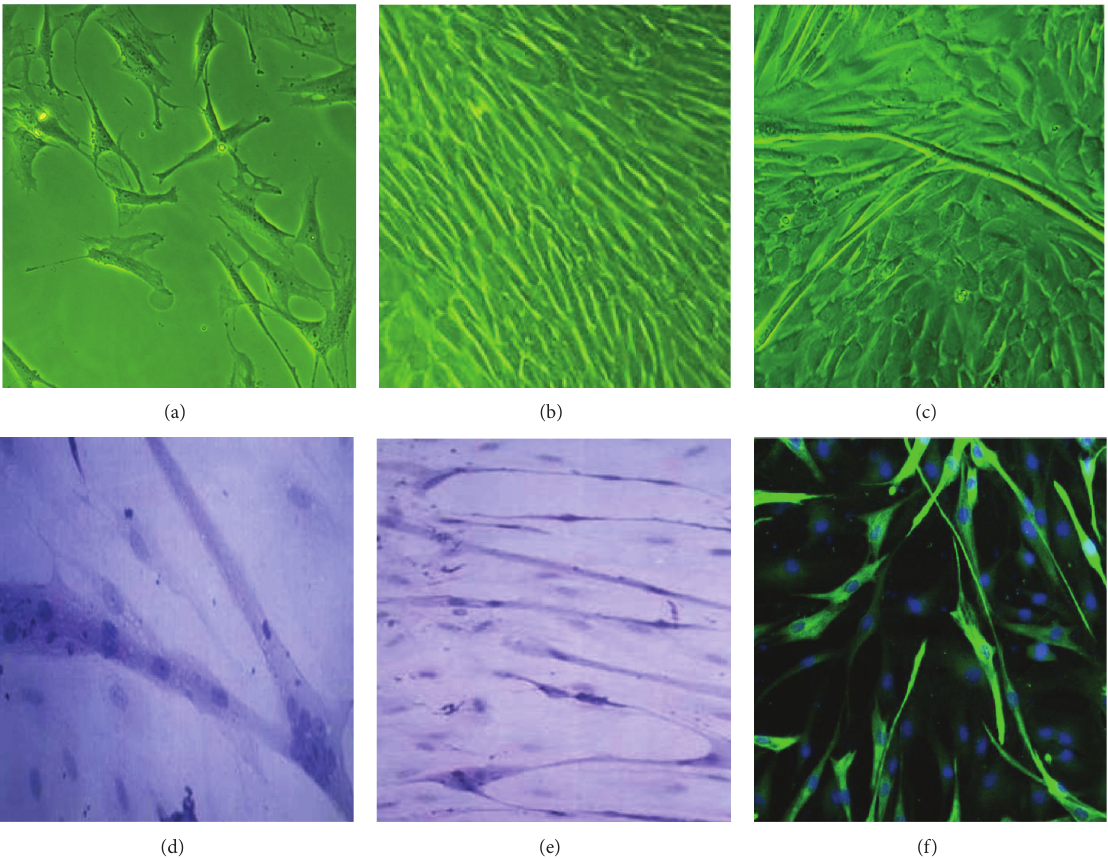
Figure 1: Morphological features and immunocytochemical identification of the primary myoblasts under inverted microscope and LSCM, respectively, (a, b) characteristic morphology of primary cultured myoblasts; (c) differentiated myoblasts to form linear and bifurcate myotubes; (d, e) multinucleated myotubes visualized by HE staining; (f) myoblasts with desmin-positive expression presented double green and blue fluorescence under LSCM.